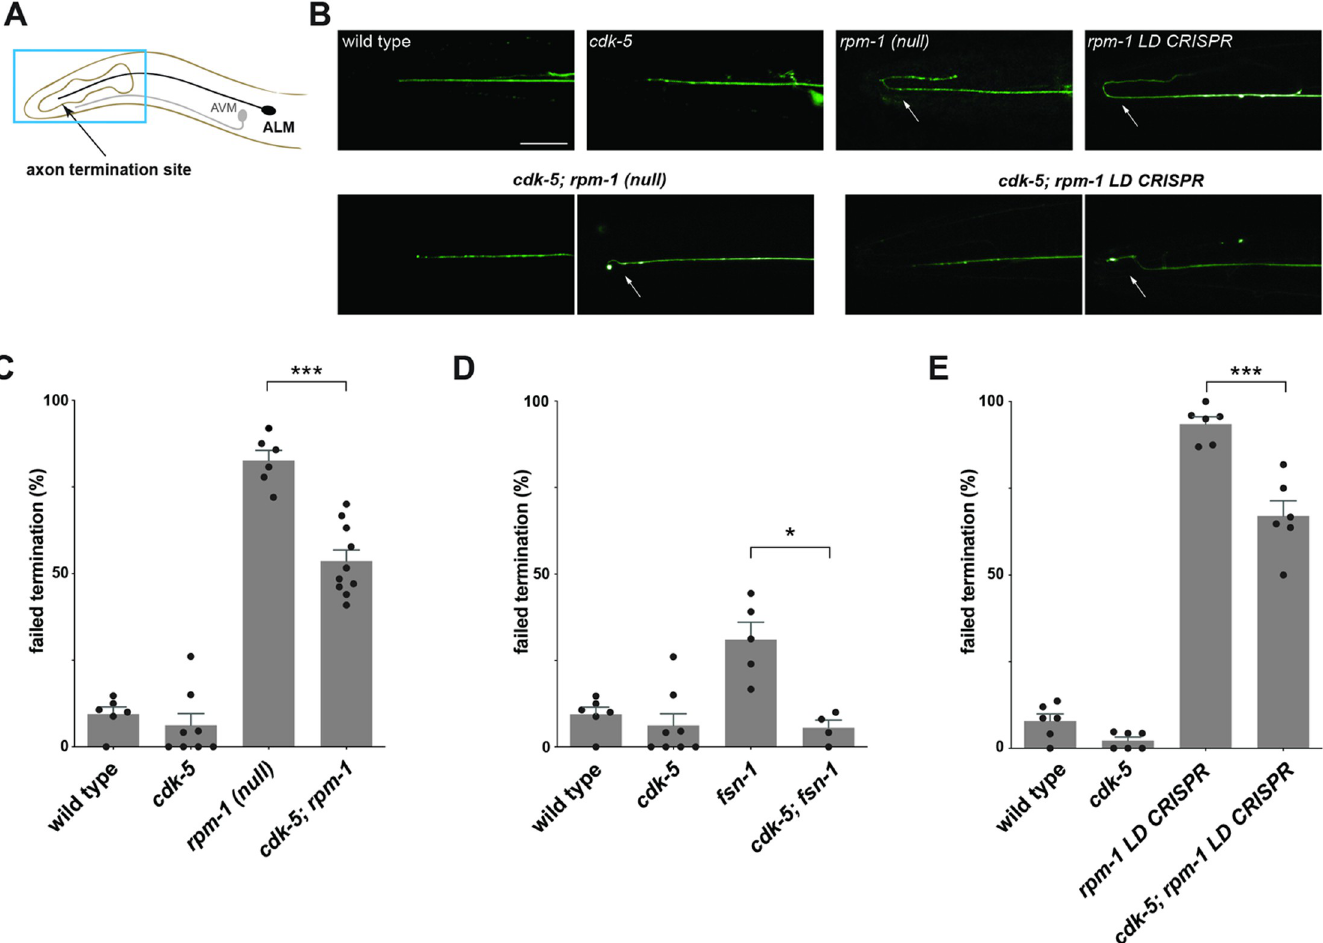
Fig 3. RPM-1/FSN-1 ubiquitin ligase complex activity inhibits CDK-5 to regulate axon termination in C . elegans . A ) Schematic shows axon termination sites for anterior mechanosensory neurons, ALM and AVM, of C . elegans . B ) Representative images of axon termination in ALM neurons for indicated genotypes visualized using transgenic GFP ( muIs32 ). Shown are severe axon termination defects in rpm-1 (lf) mutants and rpm-1 LD CRISPR animals (arrows). Axon termination defects were not observed in cdk-5 single mutants. In cdk-5; rpm-1 double mutants and cdk-5; rpm-1 LD CRISPR double mutants two examples are shown for wild-type axon termination (left) and mild axon termination defects (right, arrows) which are both observed in these animals. C-E ) Quantitation of axon termination defects in ALM neurons for indicated genotypes. Axon termination defects are reduced in C ) cdk-5; rpm-1 double mutants, D ) cdk-5; fsn-1 double mutants, and E ) cdk-5; rpm-1 LD CRISPR double mutants compared to single mutants. For C-E, means (bars) are shown for 4 or more counts (black dots represent individual counts, 20 or more worms/ count) for each genotype. Error bars indicate SEM. Significance assessed using Student’s t -test with Bonferroni correction. ��� p < 0.001, � p < 0.05. Scale bars 20 μ m.